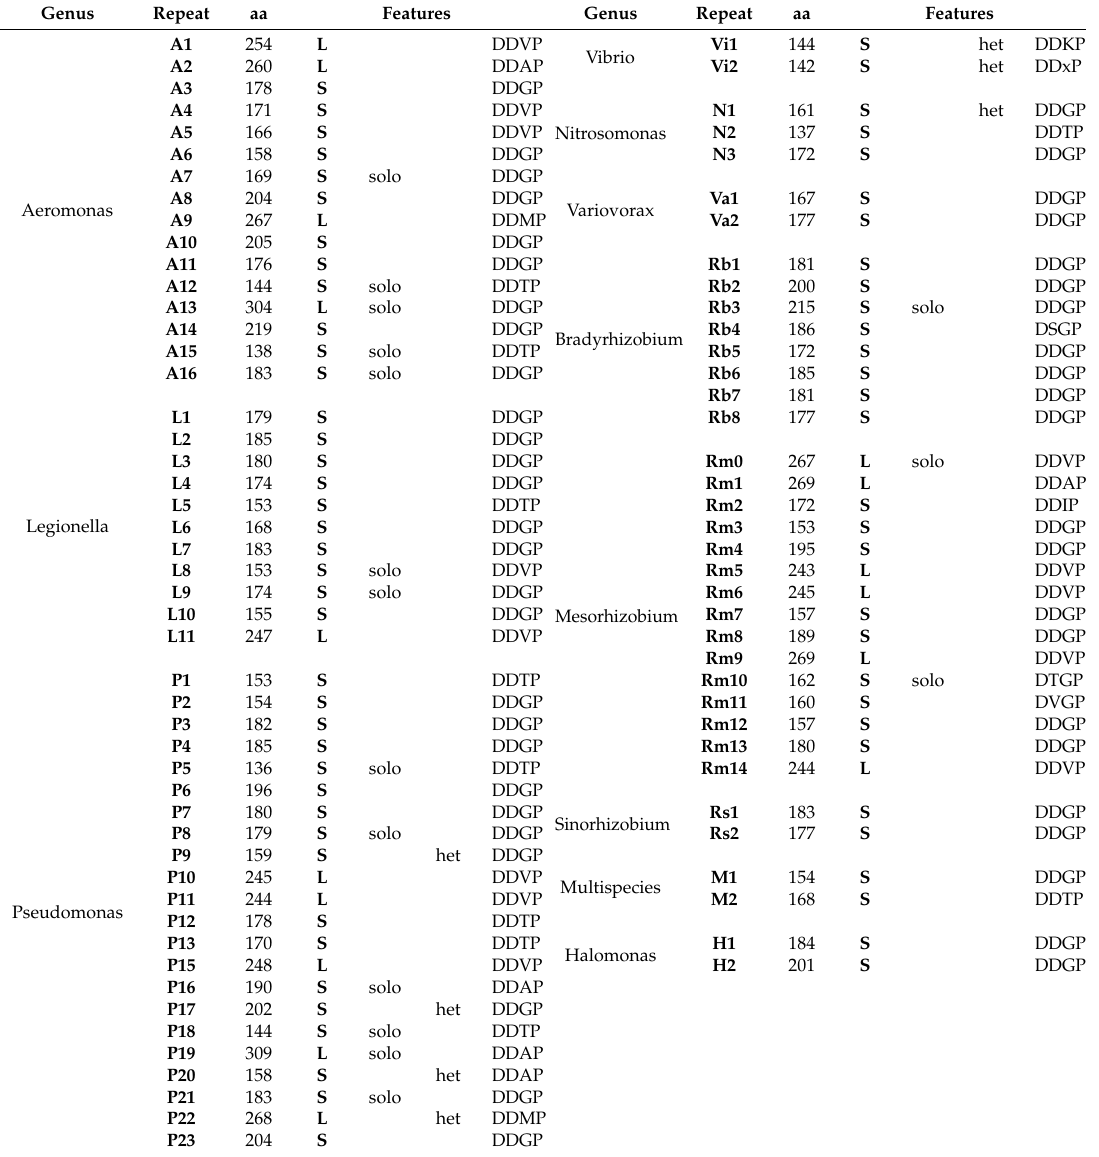
Table 1. All DDxP repeats analyzed in this